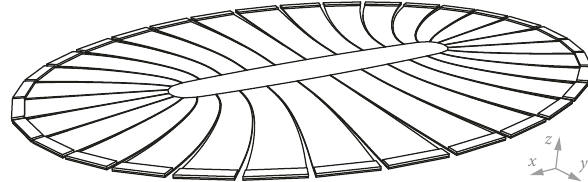
Figure 23: Flat planar formwork, ready to be lifted.